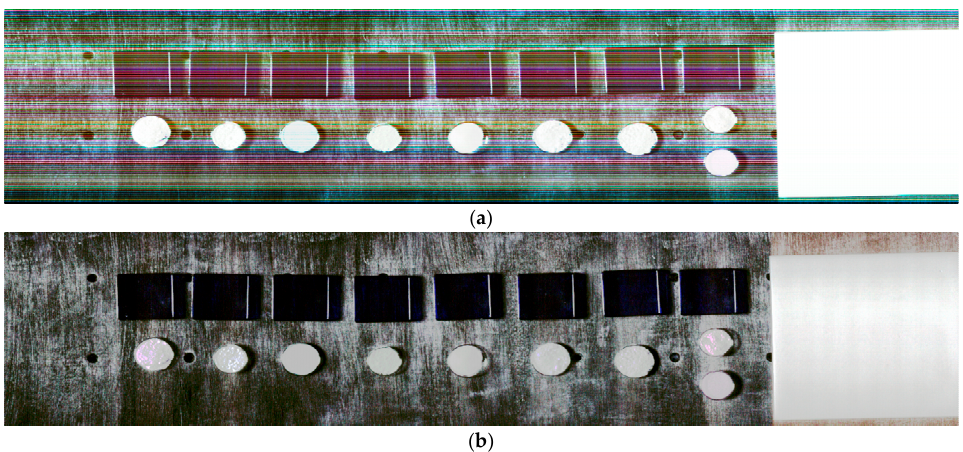
Figure 3. ( a ) False colour, raw HySPEX SWIR image (Red 2414.0955 nm, Green 2312.0591 nm, Blue 2210.0225 nm), ( b ) False colour, radiometrically scaled HySPEX SWIR image (Red 2414.0955 nm, Green 2312.0591 nm, Blue 2210.0225 nm).